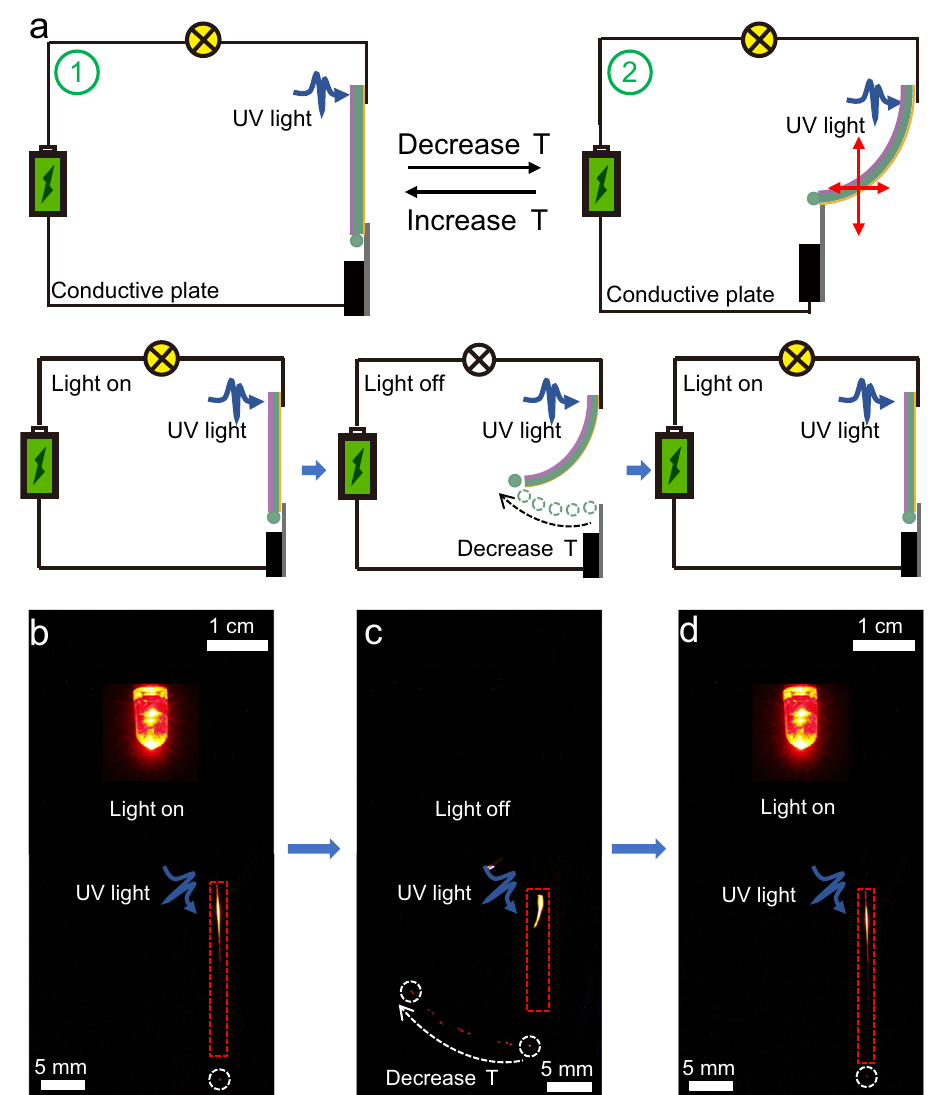
Fig.4|Hybridorganiccrystalsasopticalandelectricalswitchesfordualsignal transmission. a Schematic diagram of optical/electrical dual signal temperature switching of an electrical circuit at ambient temperature (1) and upon cooling (2). The position of the free end of the bent crystal depends on the temperature, and the conductive plate assures current fl ow (The optical signal transmission is represented by the green circle). b ‒ d Schematic of an optical/electrical dual signal